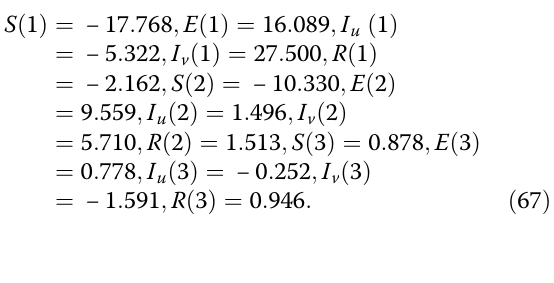
Applying the values of variables and parameters in Table 1 together with the initial conditions of the model, yields the following results given by